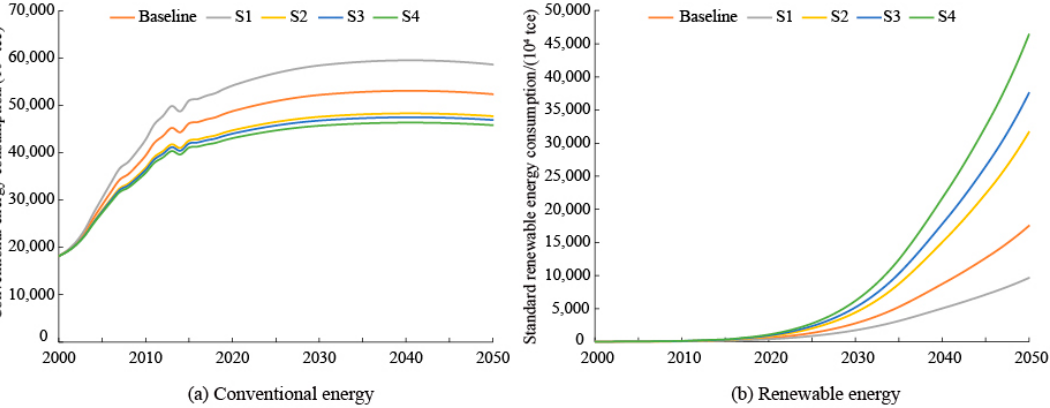
Figure 4. Conventional ( a ) and renewable energy ( b ) consumption simulation results of S1, S2, S3, S4 and baseline scenario.